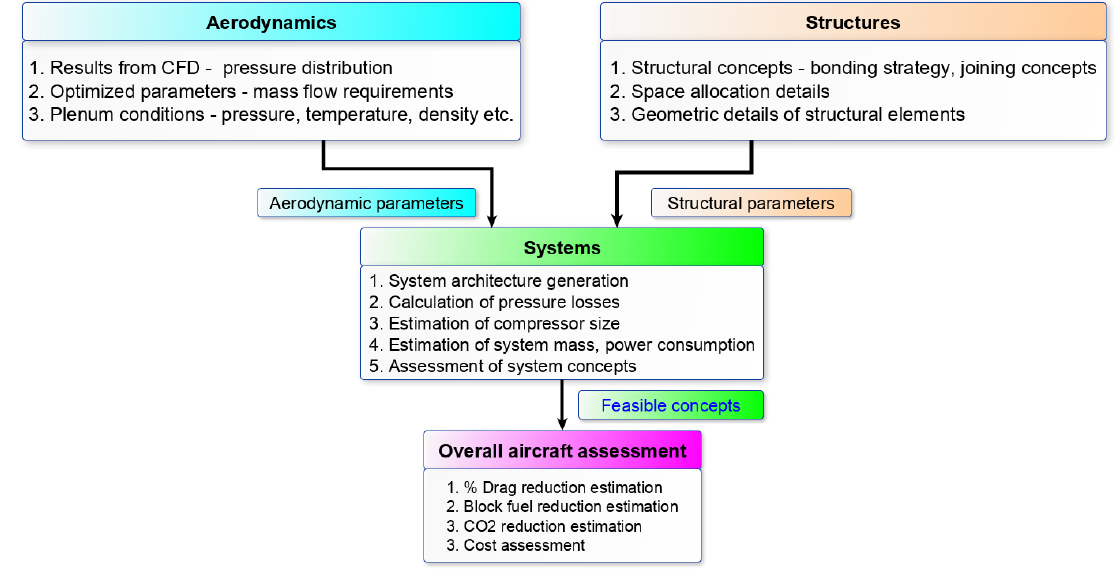
Figure 4. HLFC system concepts assessment method.